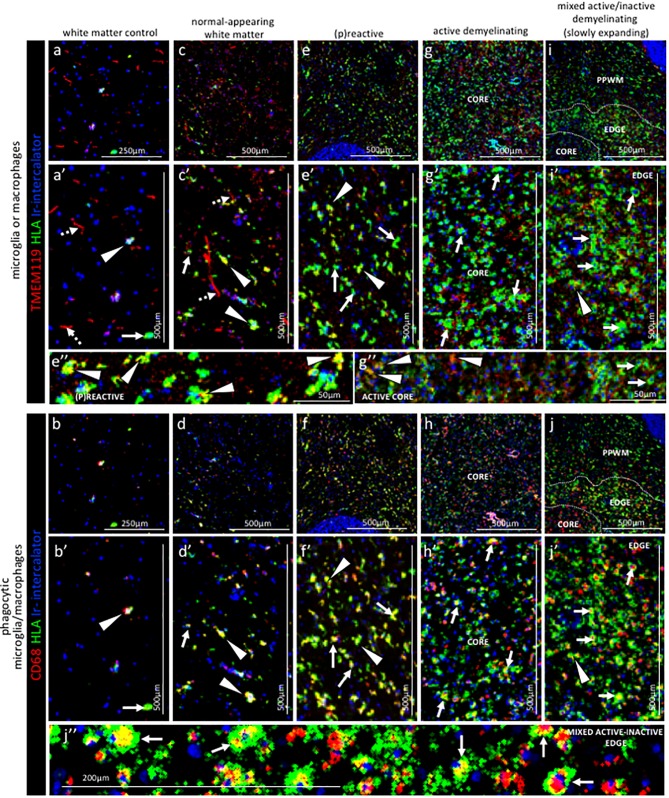
Pattern of microglia or macrophage activity in different stages of MS lesions by IMC.Representative mass cytometry images of (a, a’, b, b’) control white matter, (c, c’, d, d’) normal-appearing white matter (block no. CR4A), (e, e’, f, f’) (p)reactive lesion (block no. CR4A), (g, g’, h, h’) active demyelinating lesion (block no. CR4A) and (i, i’, j, j’) mixed active-inactive demyelinating lesion (block no. CL3A). For each region of interest, we show the same area simultaneously labeled with markers of antigen presentation (human leukocyte antigen, HLA) to detect microglia and/or macrophages, TMEM119 to detect microglia, lysosomes (CD68) to detect phagocytic cells and DNA (Ir-intercalator). (a, a’– i, i’) Overlay of TMEM119 (red), HLA (green) and Ir-intercalator (blue) identifies (dotted arrows in a’ and c’) TMEM119+HLA- resting microglia with thin elongated processes and (arrows head in a’,c’, e’, i’ and e’’) TMEM119+HLA+ activated microglia or (solid arrows in a’, c’, e’, g’, i’ and g’’) TMEM119-HLA+ activated macrophages. (b, b’–j, j’’) Overlay of CD68 (red), HLA (green) and Ir-intercalator (blue) identifies HLA+CD68+ phagocytic microglia/macrophages. PPWM, periplaque white matter; BV, blood vessel.